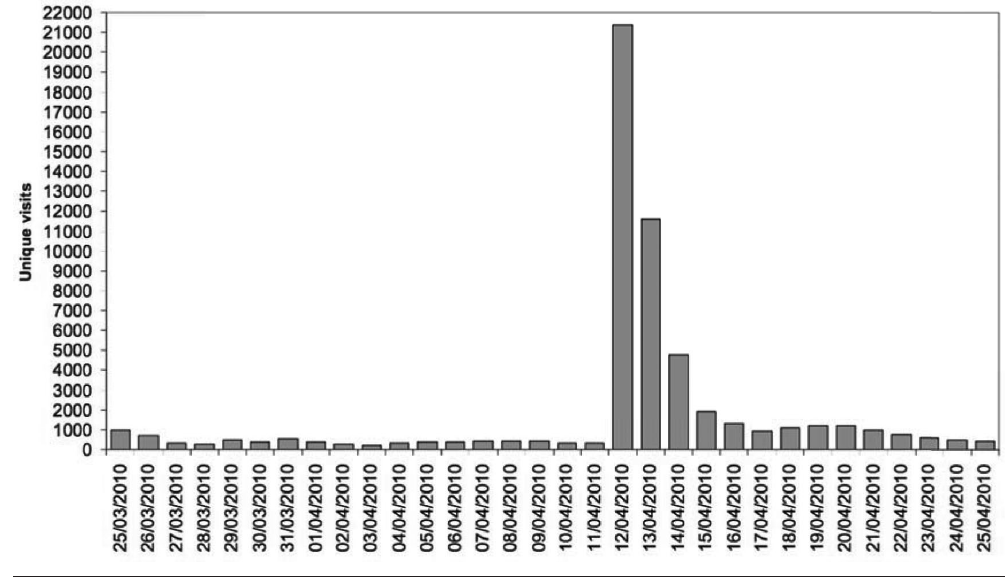
Figure 3A: Examples of evidence for ‘significance’ of impact from engagement with traditional media, consistent with our specific goal of ‘generating curiosity about science’: data showing more than a hundred-fold increase in daily visitors to our own engagement website coincident with media coverage of our research on 12 March